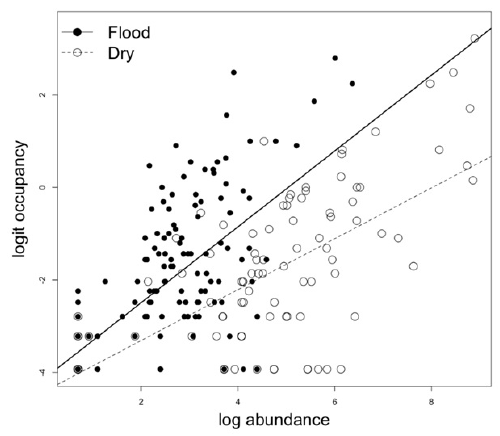
Figure 2. Relationship between occupancy and abundance of zooplanktonic taxa in the Araguaia River floodplain in two hydrological periods (flood and dry seasons; January 2006 and July 2006,